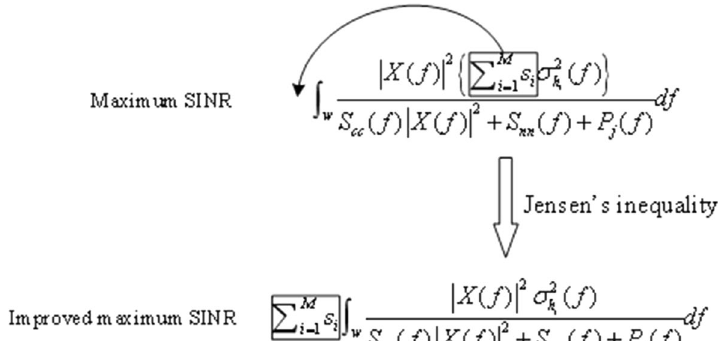
Fig. 16 Change in expressions of maximum SINR and improved maximum SINR